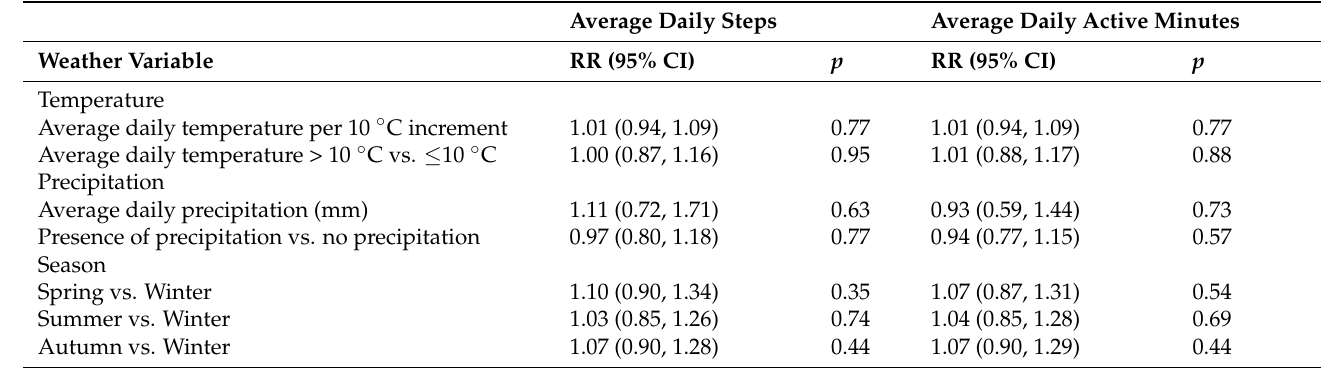
Table 3. Association of weather and season variables with average daily steps and non-sedentary active minutes (N = 243) 1 . Average Daily